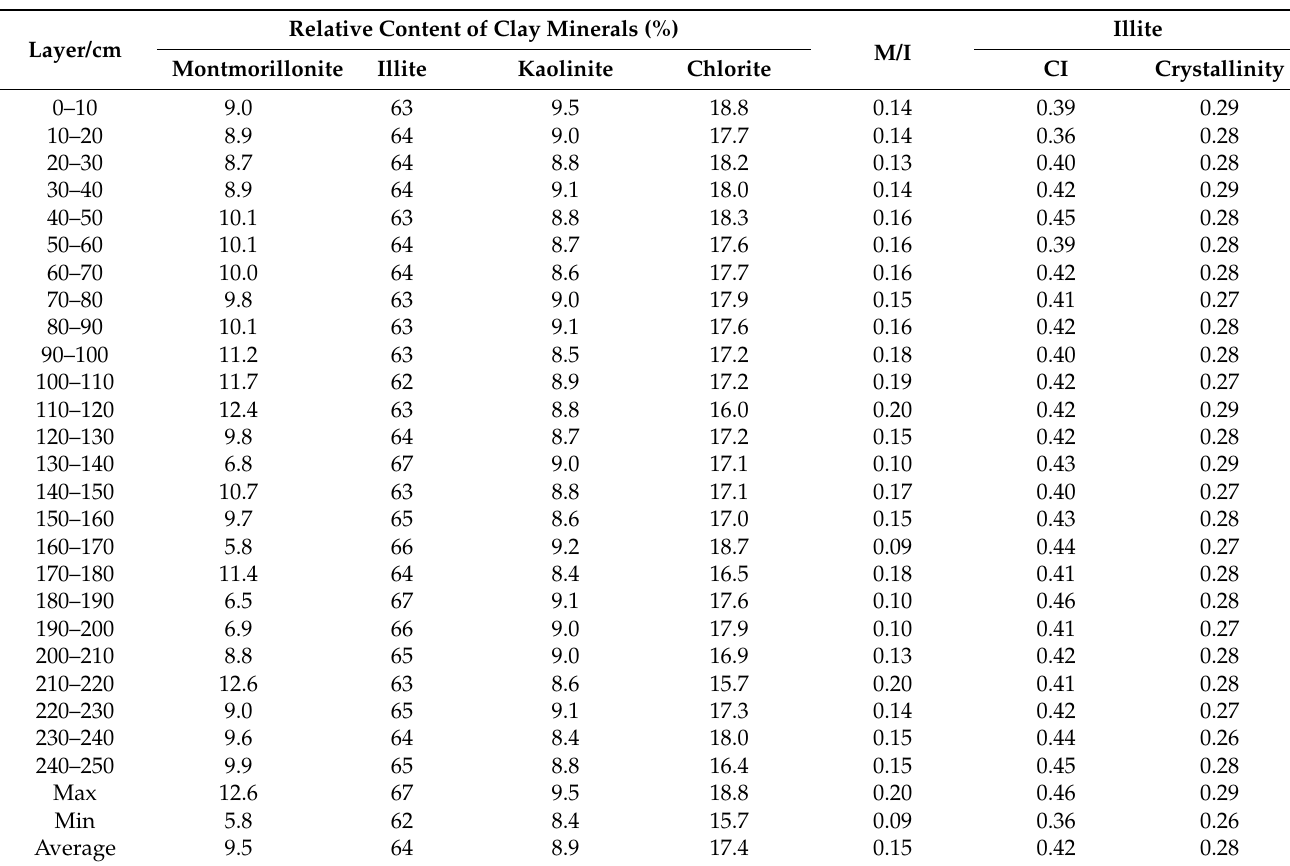
Table 1. Clay minerals compositions of GC1601.